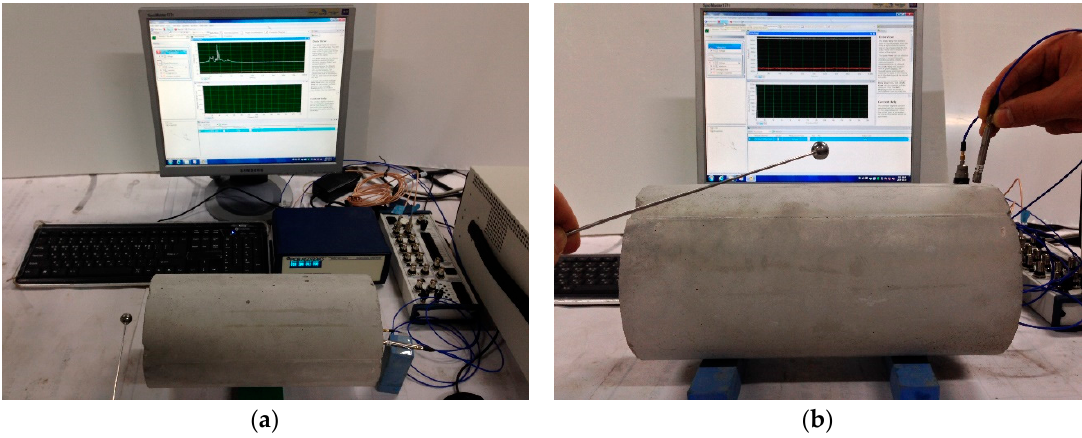
Figure 3. Resonance frequency test for ( a ) longitudinal mode and ( b ) transverse mode.